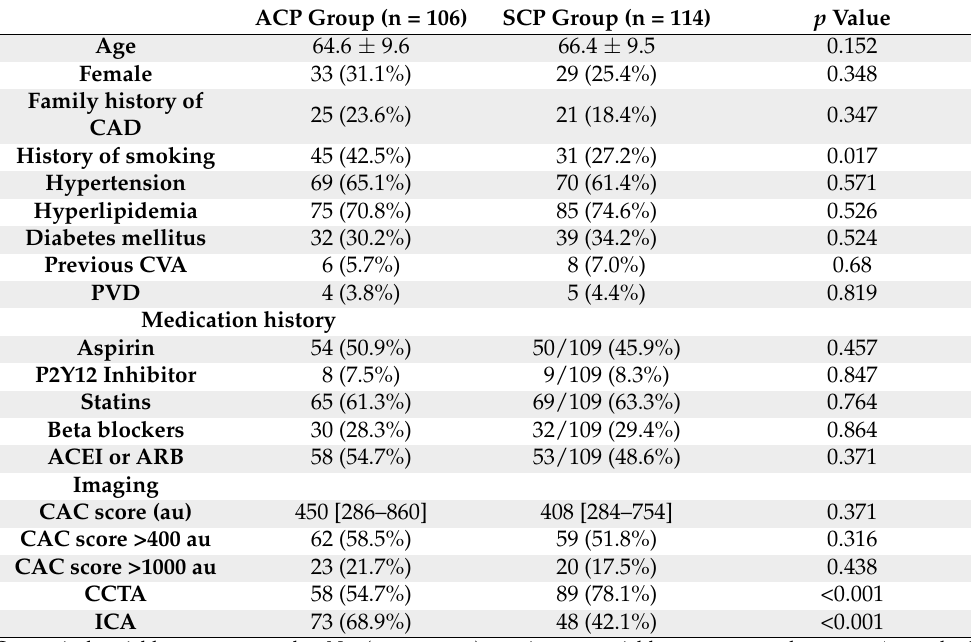
Table 1. Baseline characteristics, medication and imaging characteristics.